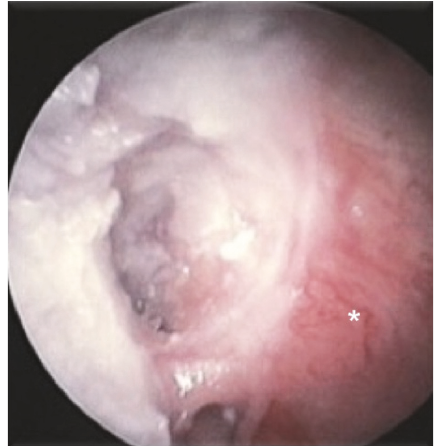
Figure4:Sixmonthspostoperatively,apartiallyepithelizedmastoid bowl (asterisk) with an intact tympanic membrane was seen.